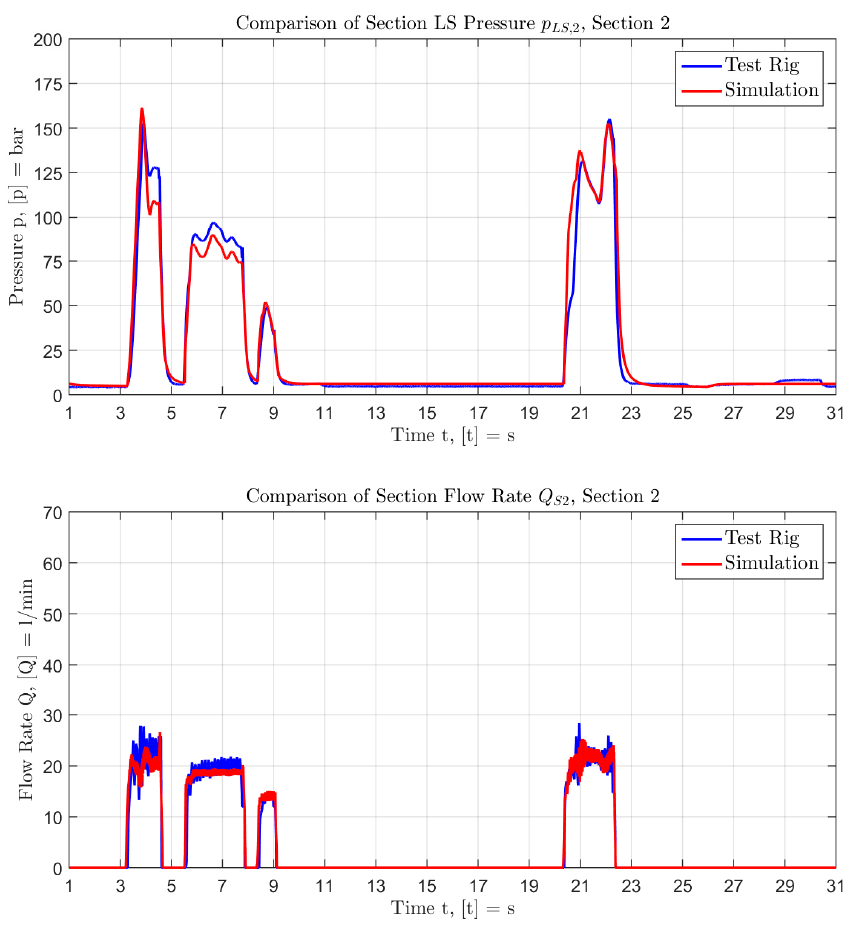
Figure 15. Results Section 2: LS pressure ( top ), flow rate ( bottom ) [9]. Reproduced with permission from the publisher.